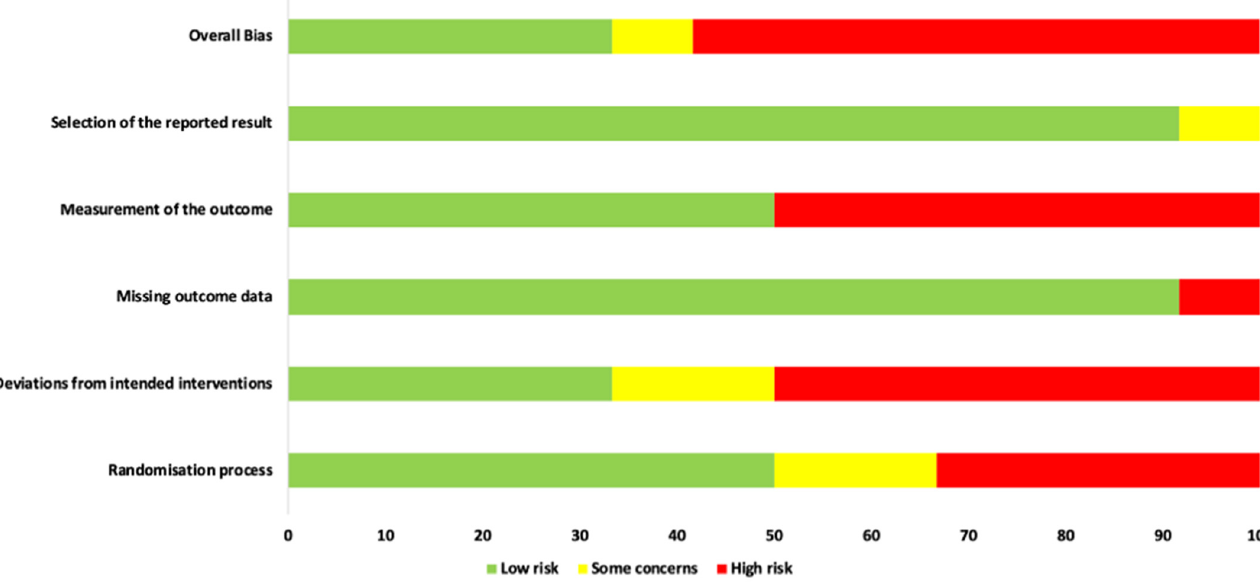
Figure 4. Risk of bias assessment graph of the included studies expressed as percentages based on the consensual answers of two individual assessors (R.H. and S.D.).